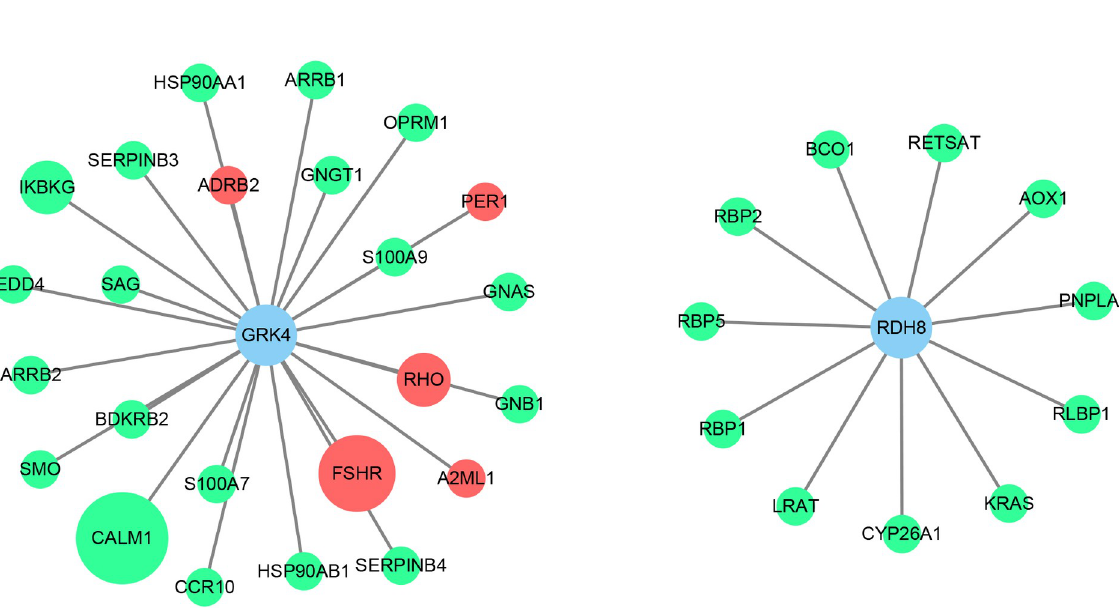
hypertension vary with ethnicity and regions. For example, CAMK4 rs10491334 is associated with hypertension in Uyghur population; whereas GRK4 rs180105 in East Asians and Europe- ans; and GRK4 rs2960306 in Europeans [32]. Abnormalities in SNS and RAS functions con- tribute to pathogenesis of hypertension. Therefore, among Han population in Xinjiang, SNS, RAS and candidate genes are hypothesized to play roles in etiology of hypertension. In order to verify this conjecture, we have collected 151 hypertension cases and 65 controls, selected 54 genes related to SNS and RAS for targeted sequencing, and identified SNPs of genes related to hypertension. Notably, GRK4 rs1801058 ( p . V486A ) and RDH8 rs1644731 ( p . M222T ) were related to hypertension. Upon mutation was introduced, 3D protein structure,